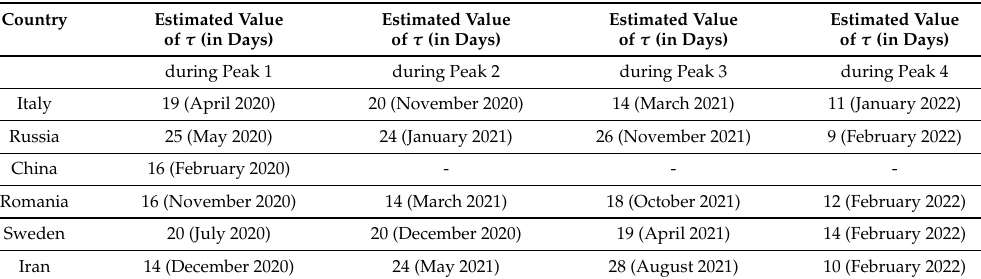
Table 2. Estimated value of τ for different countries during different outbreaks of the COVID- 19 epidemic. The months indicated in the table correspond to the time when the corresponding peak appeared. Country Estimated Value Estimated Value Estimated Value Estimated Value of τ (in Days) of τ (in Days) of τ (in Days) of τ (in Days) during Peak 1 during Peak 2 during Peak 3 during Peak